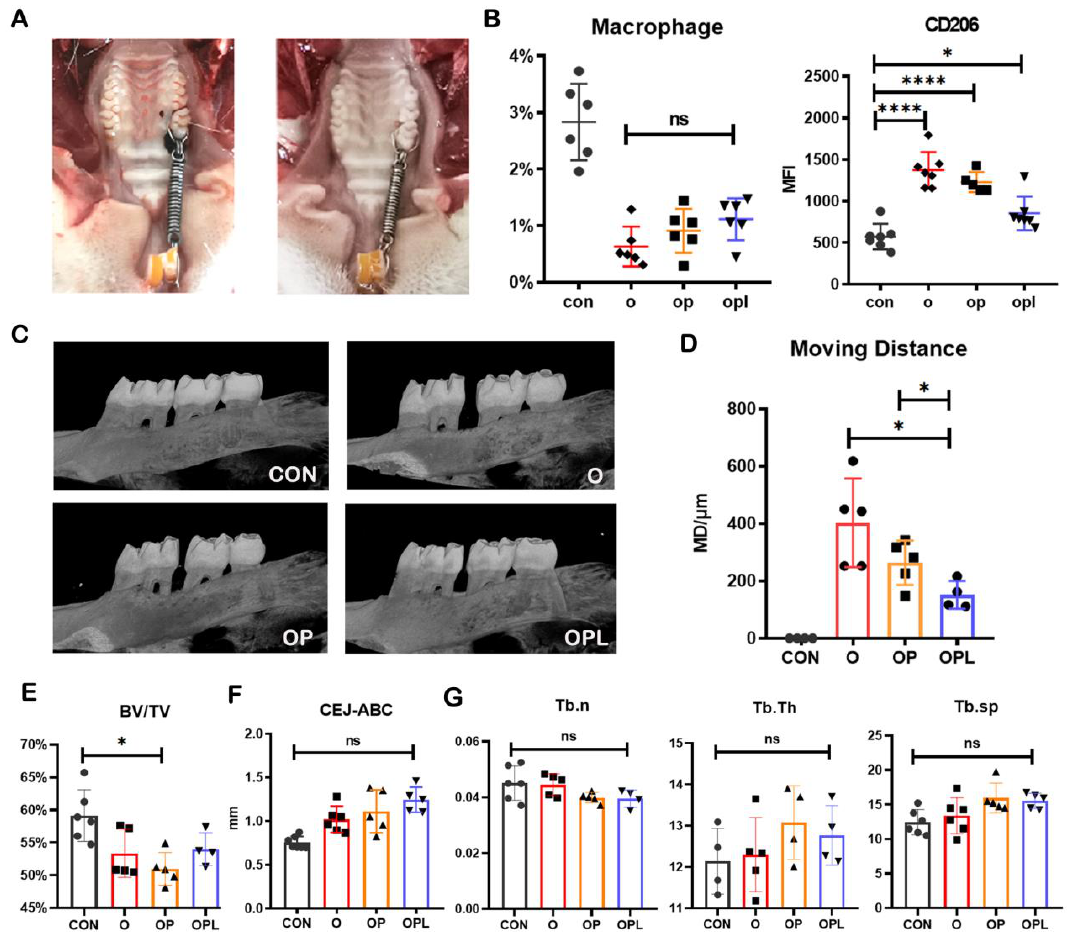
Figure 2. Effects of the inflammatory environment on the macrophage and orthodontic tooth move- ment efficiency. ( A ) The left side of the figure shows an orthodontic model in a periodontitis environment. A loop of silk thread was used at the neck of the first molar to establish the periodontitis environment. On the right is an orthodontic model in a normal environment. ( B ) Flow cytometry was used to detect the proportion of macrophages and the content of polarization markers in the periodontal tissue of each experimental group and control group. ( C ) Micro-CT images of the alveolar bone. The distances of tooth movement and the surrounding cementum are shown for each experimental group and control group. ( D ) Orthodontic tooth movement distances in each group. ( E ) Values of BV/TV for each group. ( F ) CEJ-ABC distances. ( G ) Various parameters of bone trabec- ulae. Values are presented as means ± SD. Note: * p < 0.05, **** p < 0.0001, ns = no significance; n = 4 – 7. 3.3. The Periodontal Microenvironment Is an Important Factor in Determining the Rate of OTM The specimens were next sectioned and stained to evaluate the reasons for the differ-